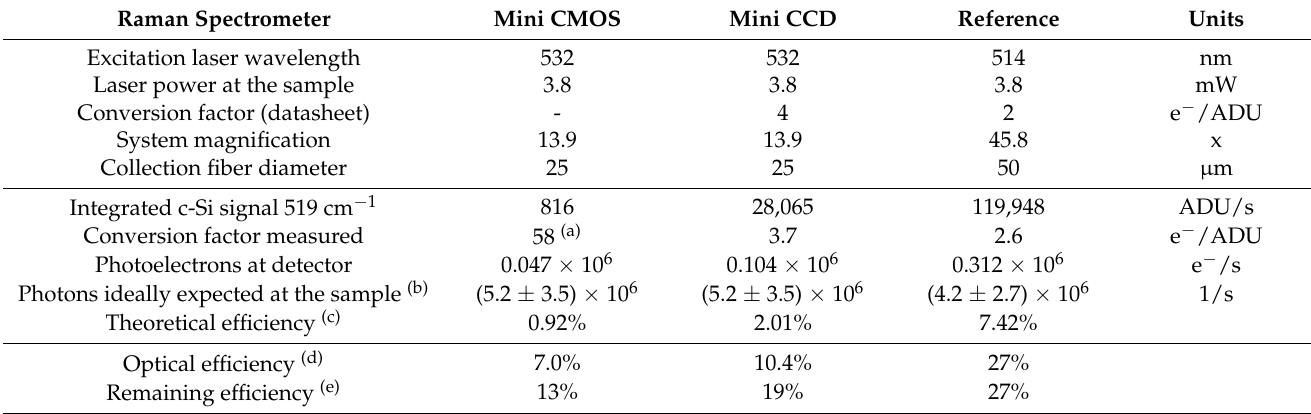
Table 1. Efficiency comparison between the three different confocal Raman spectrometers and the ideal Raman micro- spectrometer. Note that the product of optical efficiency and remaining efficiency gives the theoretical efficiency. Note also that the data refers to the detection in the entire confocal Raman spectrometer (consisting of microscope, fiber coupling and spectrometer with sensor) and not only to the spectrometer (see Section S4 of the Supplementary Information for